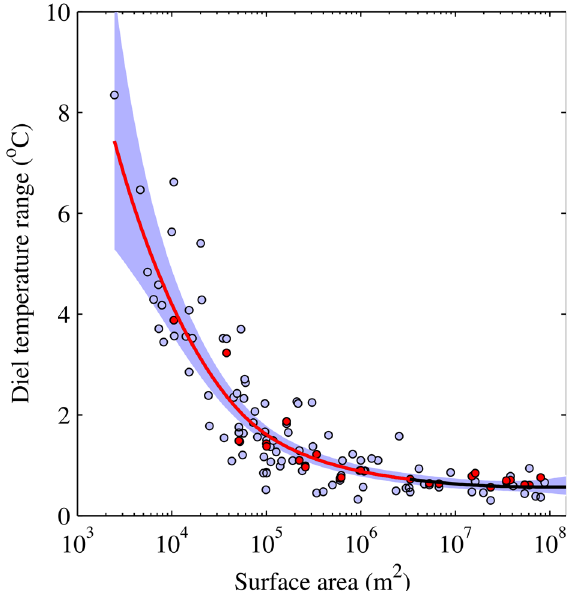
Fig 3. Relationship between the diel range in lake surface water temperature and surface area. Relationship between the observed (light violet circles) and theoretical (red circles) diel surface temperature range with lake area during summer, with the solid line illustrating the fitted generalised additive model with 95% confidence interval shown by the shaded region; lake surface areas where the diel temperature range changes significantly (P < 0.001) are shown with a red